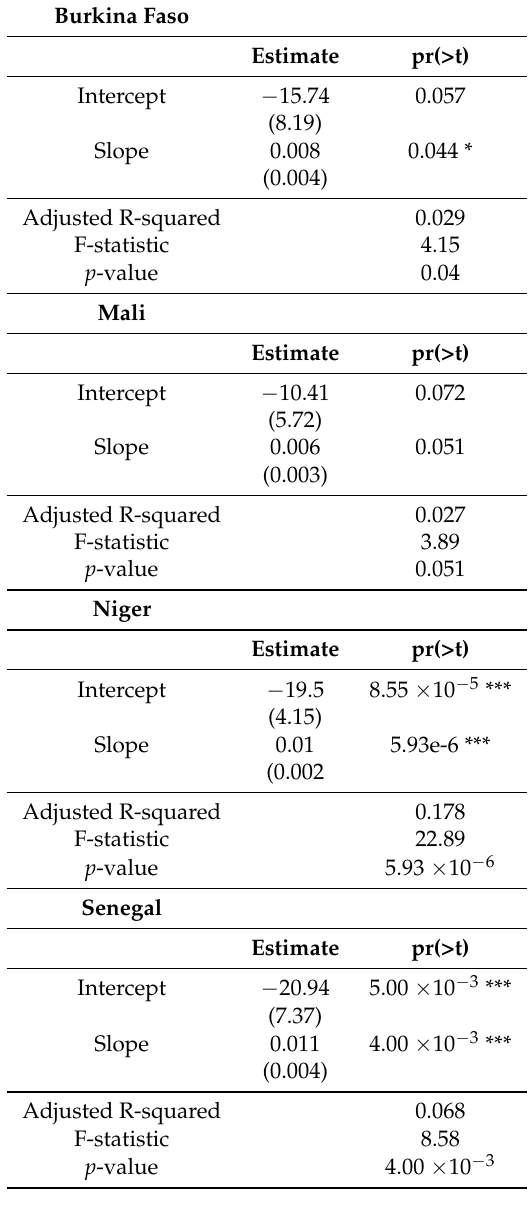
Table A2. Numbers within the brackets () represent the standard error of the estimate directly above themselves. Different p -values are used to determine significance—* represents estimates that p -values smaller than 0.05, and *** represent estimates that have p -values smaller than